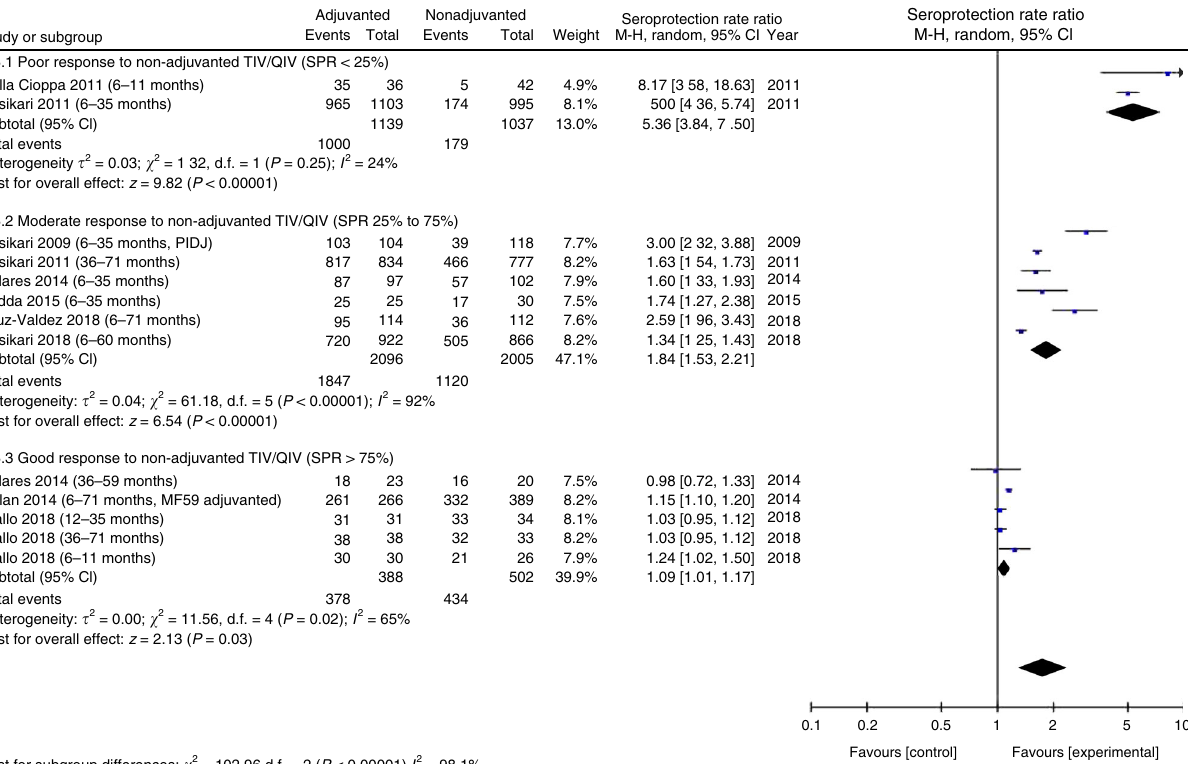
Test for subgroup differences; (cid:2) 2 = 102.96 d.f. = 2 ( P < 0 00001) I 2 = 98.1% Fig. 7 Forest plot showing the ratios of the seroprotection rate (SPR) against B, de fi ned as a ≥ 1:40 hemagglutinin inhibition (HI) titer, 21 – 28 days after the second dose among children who received adjuvanted versus non-adjuvanted trivalent vaccines (TIVs) or quadrivalent vaccines (QIVs).